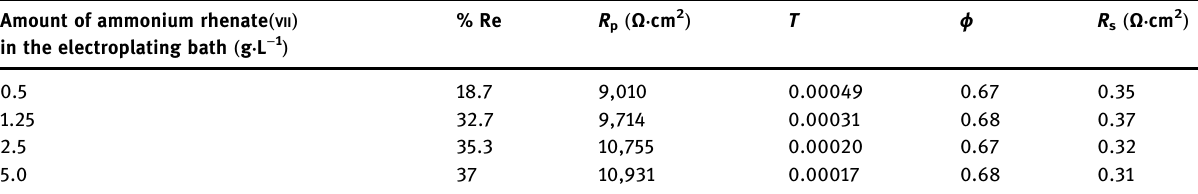
Table 2: Equivalent circuit parameters obtained on the basis of EIS data depending on the rhenium content in the Ni – Re coating Amount of ammonium rhenate ( VII ) in the electroplating bath ( g · L − 1 )